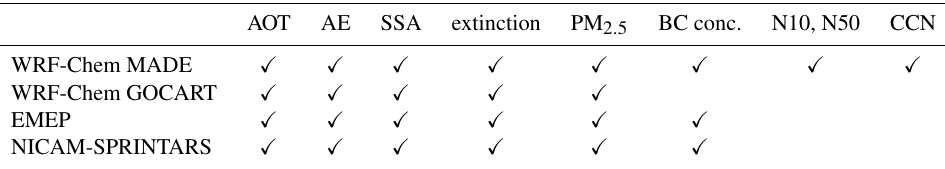
Figure 2. Comparison of observed (GPCP) and modelled daily 1 ◦ × 1 ◦ precipitation for specific months. The blue line represents the model data (see Table 1), the red line the observations for individual years (2000–2010). Table 2. Simulated